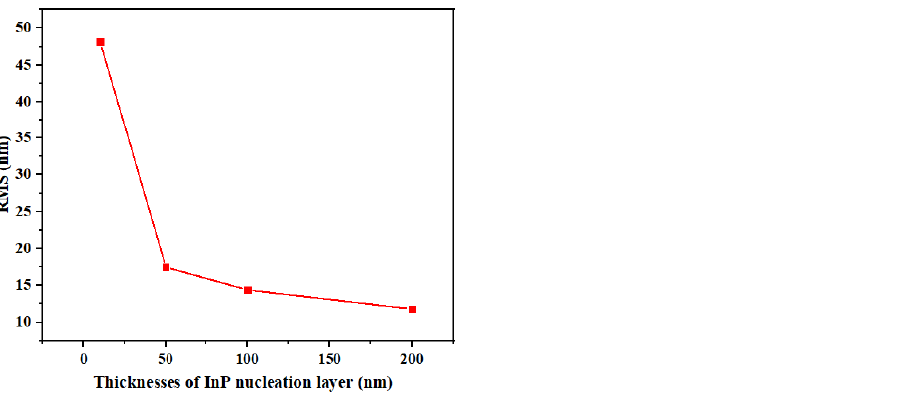
Figure 3. Plot of the RMS roughness of InP films versus different thicknesses of InP nucleation layer. TEM was used to investigate the microstructure of InP epilayers with 200 nm InP nucleation layer thickness. Because of the large lattice mismatch between the InP nucleation layer and Si substrate, it can be found that the InP nucleation layers tend to release the strain energy by an island growth: at the initial growth stage, the morphology of InP epilayers was changed from near-amorphous morphology to large islands with different sizes, and the phenomenon of island merging is obvious in Figure 4a. Meanwhile, many mismatched dislocations were generated in these islands during growth, which propagated to the surface of the material with the growth of the high-temperature InP layer, reducing the material quality of the crystal (Figure 4b).